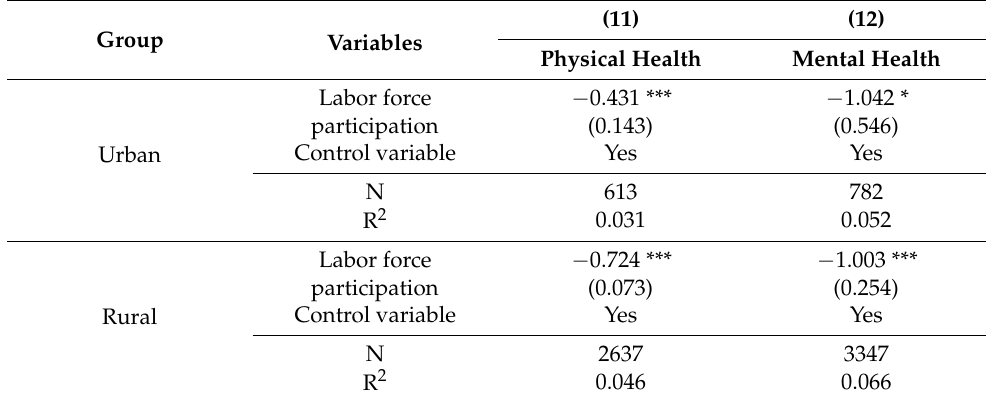
Table 8. Differences in the impact of residence type on the health status of the elderly.